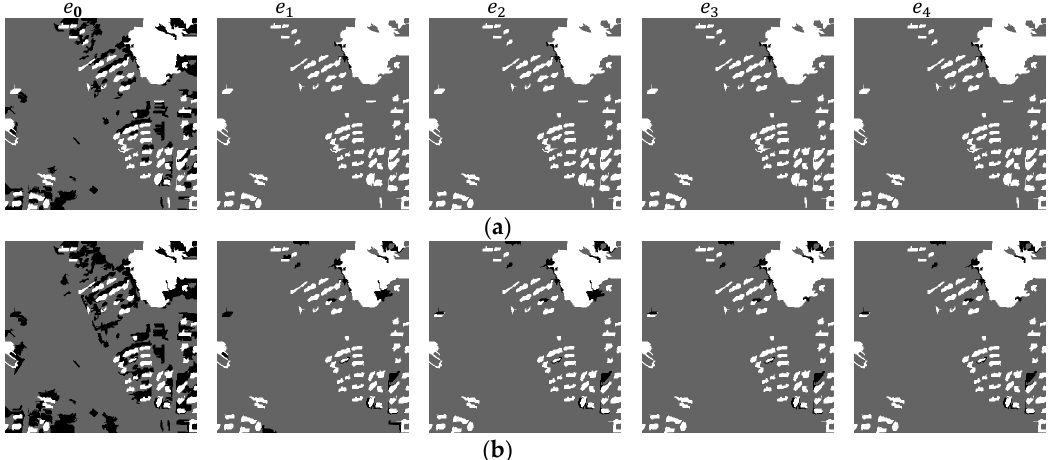
Figure 16. The CD results of the proposed methods for each epoch. The uncertainty level decreased at Site 2: ( a ) from Level 3 to Level 1; and ( b ) from Level 2 to Level 1. Grey, white, and black colors represent the change, no-change, and no-value classes, respectively. Table 5. Accuracy of the CD maps generated using the proposed method with different uncertainty levels.